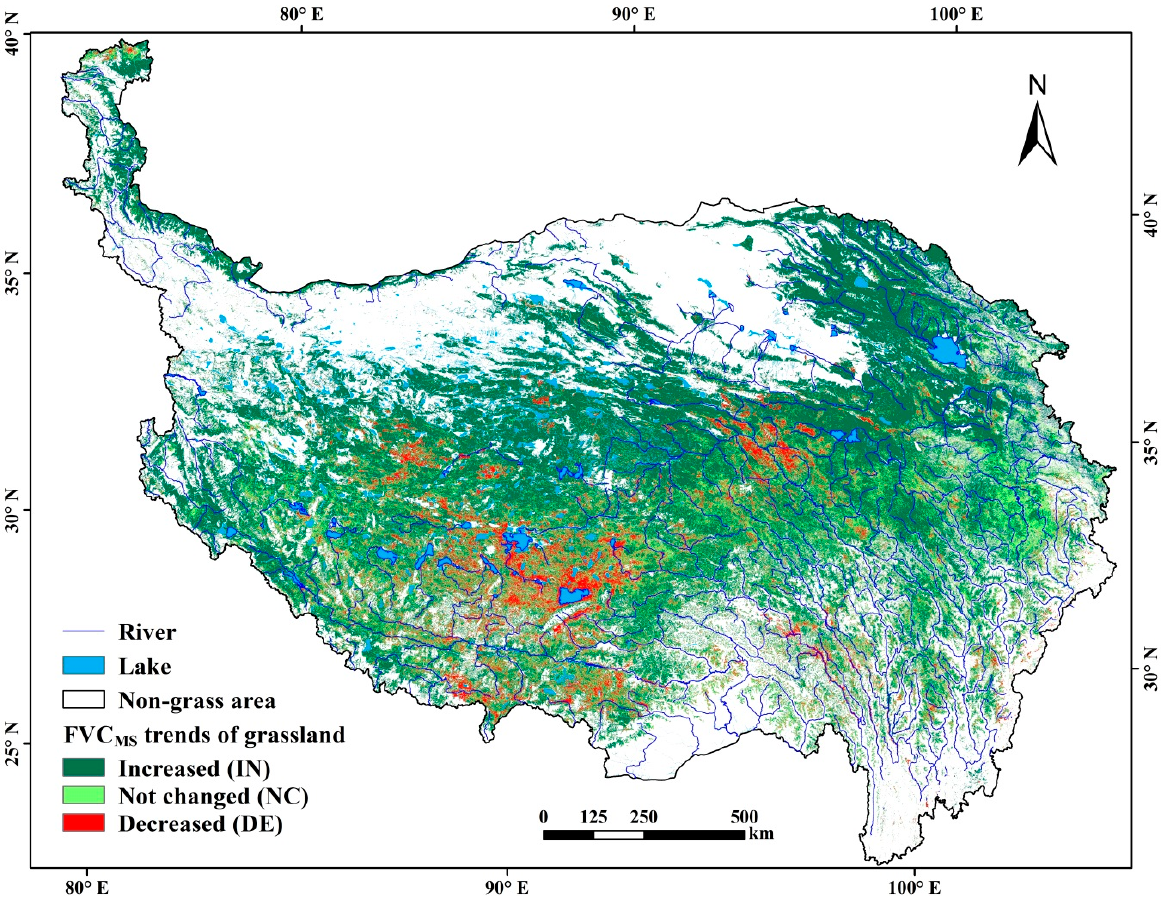
The FVC MS trends showed some differences from the FVC GP (Figure 4). By spatial analyses, it was found that 83.36% of the trends were consistent (Table 4). For the grass- lands with decreased FVC, the area covered 8.79% from FVC MS , close to 9.54% from the FVC GP trend.